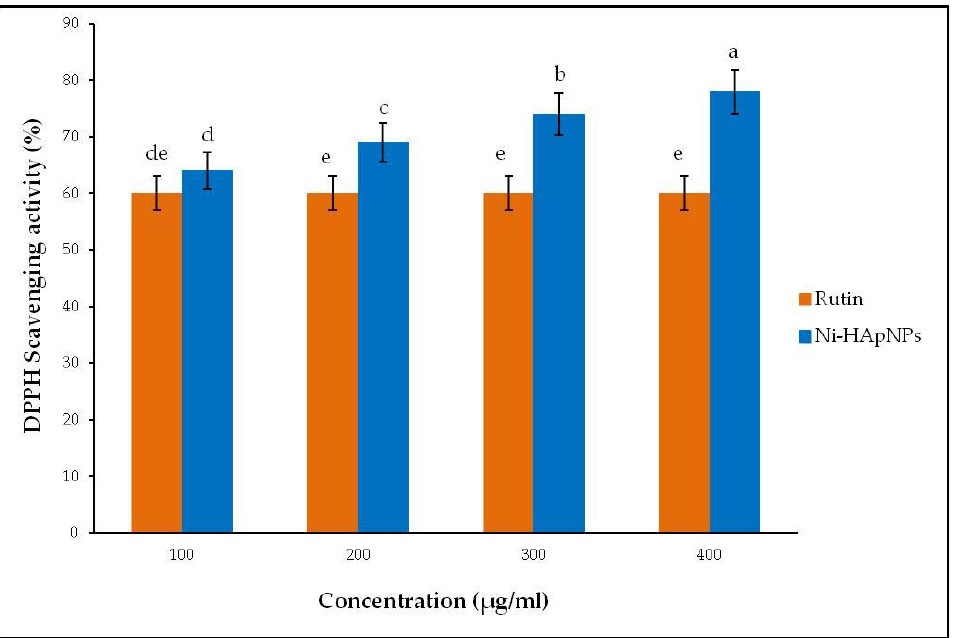
Figure 10. Antioxidant activity of Ni 2+ doped HApNPs. Different letters above each column indicate significant differences (ANOVA, Tukey’s HSD test, p < 0.05).